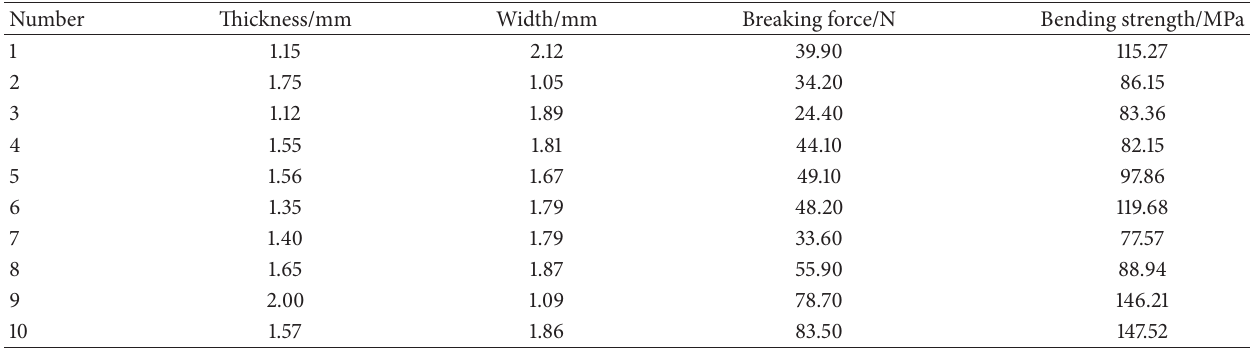
Table 4: Exact dimensions, breaking force, and bending strength of the specimens treated by fine diamond bur in a high speed hand piece (group 1). The mean value of the bending strength is 104.47MPa with a standard deviation of 26.31